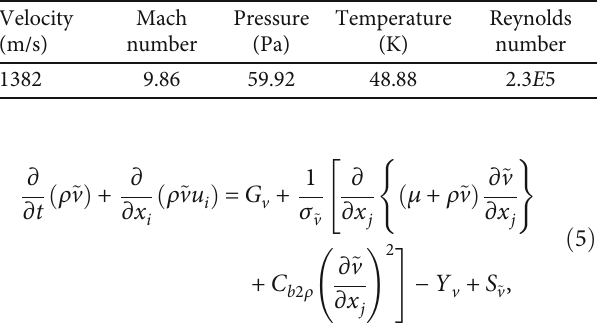
Figure 2: The diagram of (a) planar geometry and (b) the three-dimensional grid. Table 1: Freestream